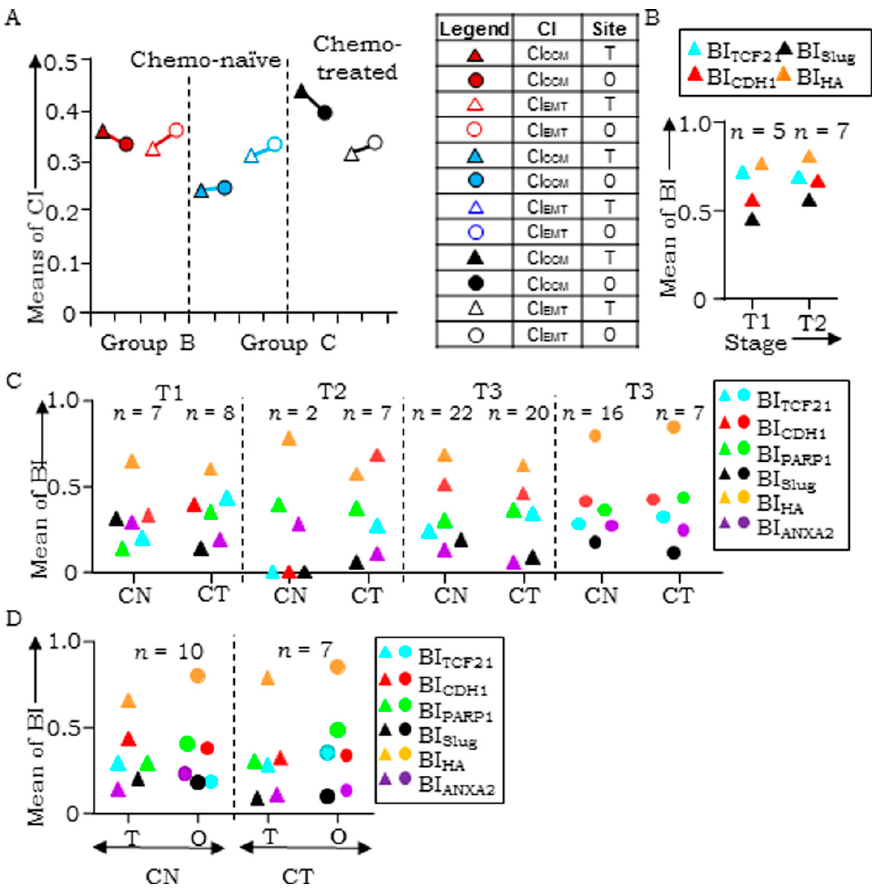
Figure 4. HGSC progression-associated marker expression. ( A ) Plot comparing CI CCM with CI EMT of tumors of Groups B and C respectively; ( B ) plot comparing biomarker (BI) scores for TCF21, E-cadherin, Slug, and HA in chemo-naïve ovarian tumors present in TMA for stages T1 and T2; ( C ) plot for chemo-naïve (left) and treated (right) paired ovarian (T)-omental (O) tumors; ( D ) plot for chemo-naïve (CN) and treated (CT) tumors at stages T1, T2, and T3 in ovarian and omental